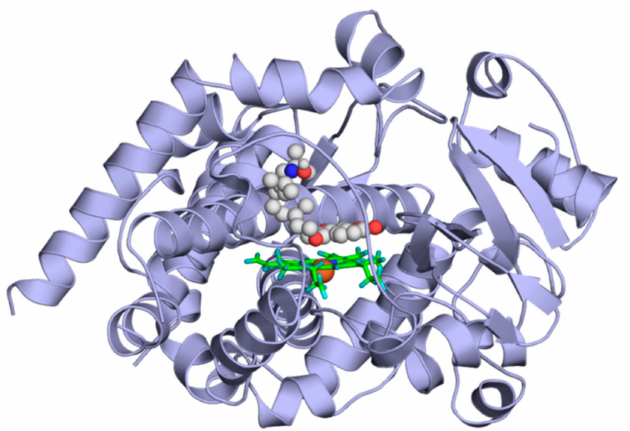
Figure 4. The binding mode of SL-BM (space-filling) as docked to the binding pocket of the CYP3A4 enzyme (light blue cartoon) above the heme ring (green sticks), where iron is represented as an orange sphere. Red spheres represent the oxygen, the blue sphere the nitrogen of SL-BM